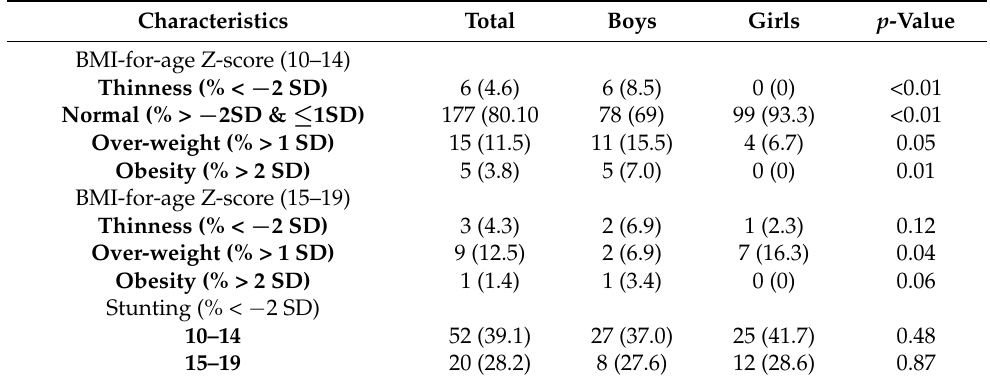
Table 2. Prevalence of thinness, overweight/obesity and stunting in afghan refugee